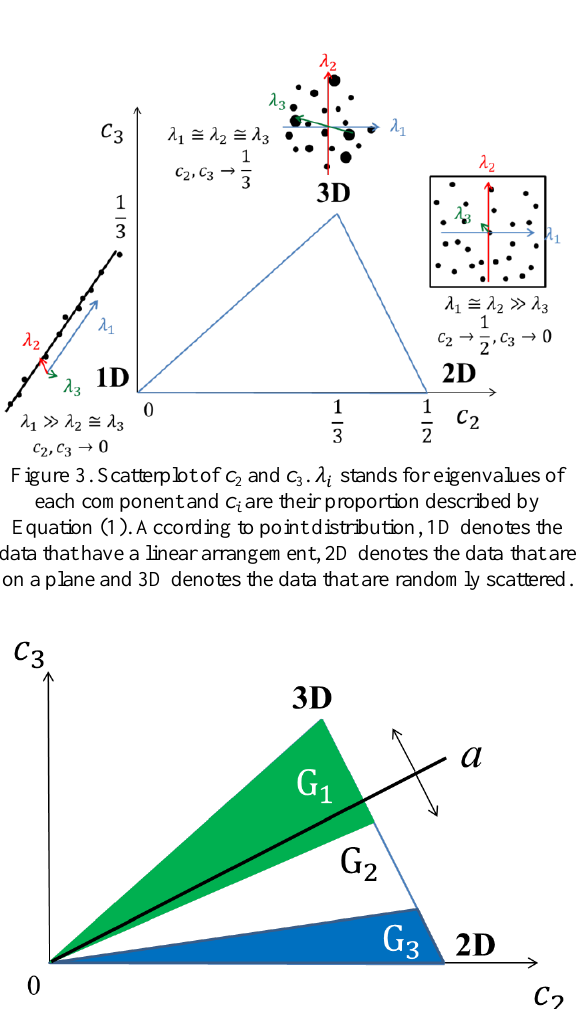
Figure 4. Classification of voxels. Using the slope a , voxels are classified into three groups, G 1 , G 2 and G 3